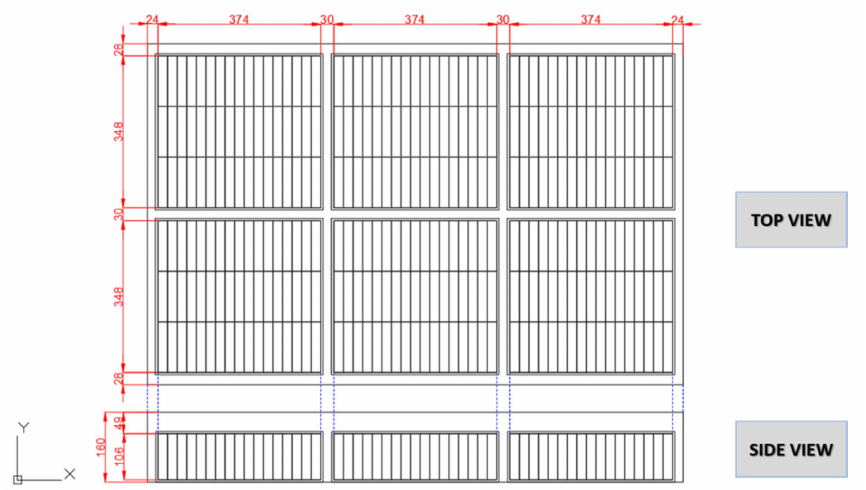
Figure 7. Pack schematic of configuration 4 with prismatic cells in the floor integration installation of reference